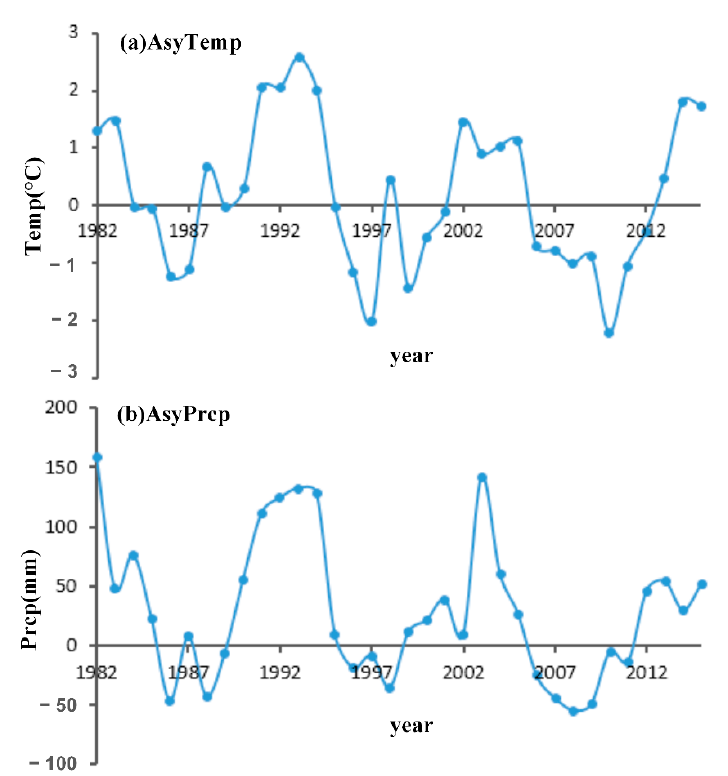
Figure 8. Interannual variability of asymmetries for temperature ( a ) and precipitation ( b ).